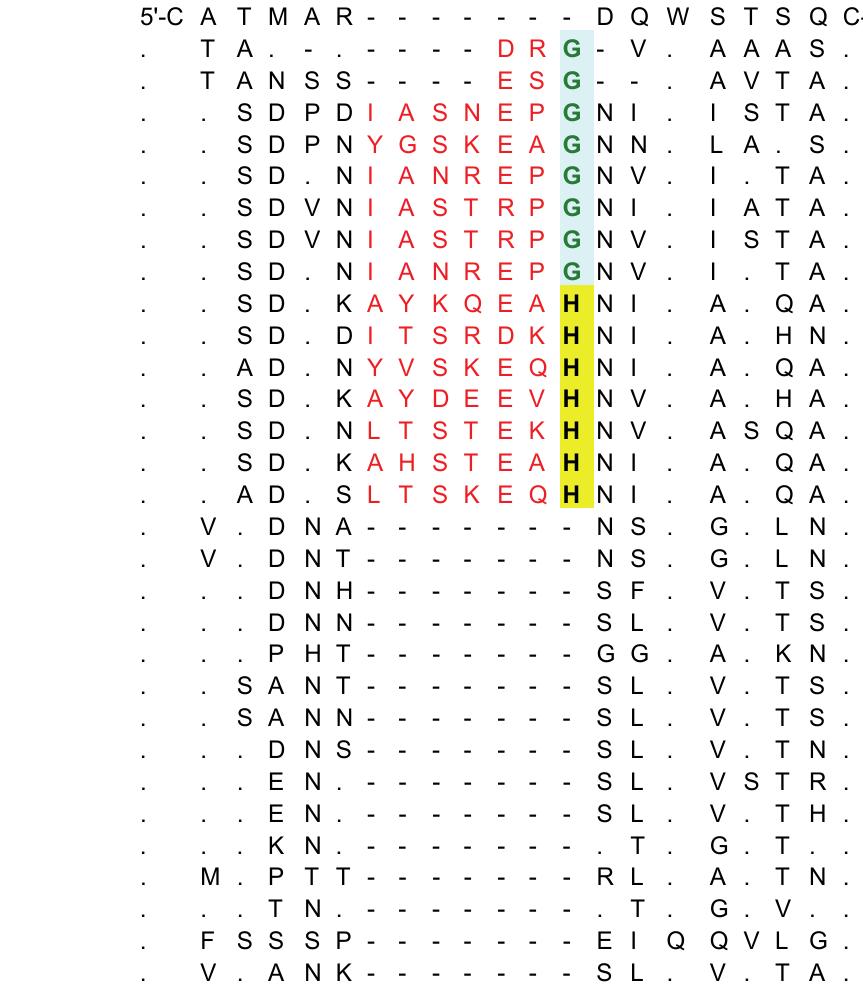
HIV-1 P SIVagi SIVrcm . - - - -